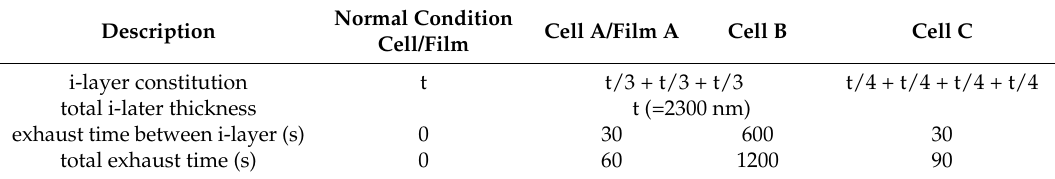
Figure 1. Cell structure comparison between normal-condition, SEG (other than cell C) and a SEG cell (cell C). The i- µ c-Si:H thicknesses were t. SEG was done when the thicknesses reached t/3 and 2t/3, t/4, 2t/4, and 3t/4. Table 1. Comparison of i- µ c-Si:H thickness constitution with normal-condition cells A, B and C; as well as normal-condition film and films A. One time of evacuations times of SEG , and total evacuations times of that with films A and cells A, B and C.